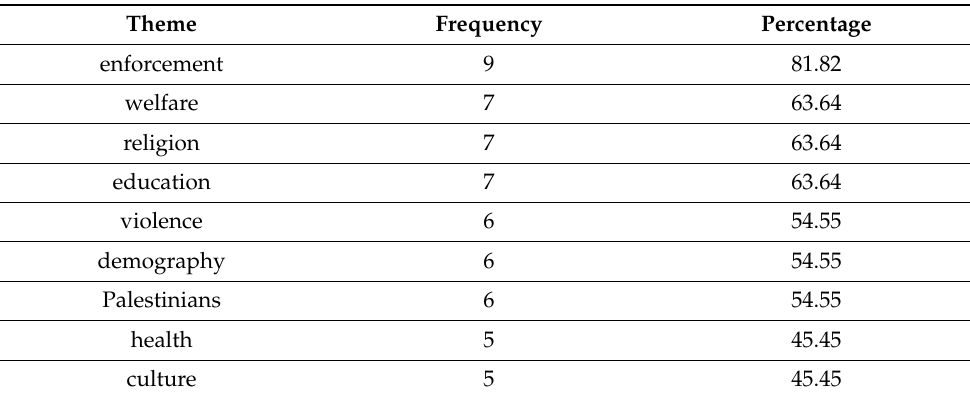
Table 5. Times of